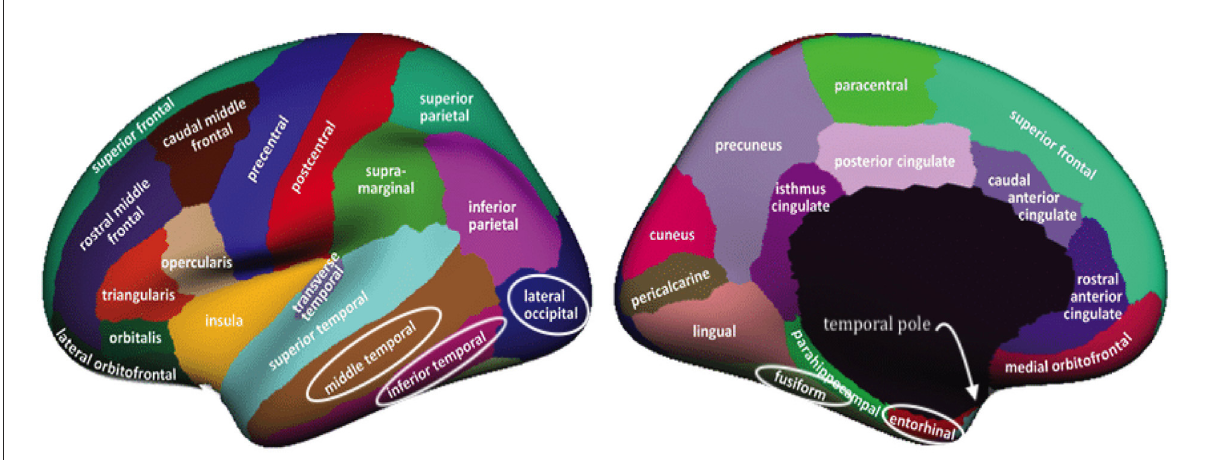
FIGURE9 Desikan-Killiany parcellation (original image from Klein and Tourville, 2012) of the left hemisphere with significant regions indicated by white loops. Regions are visible from lateral and medial perspectives ( left and right , respectively).